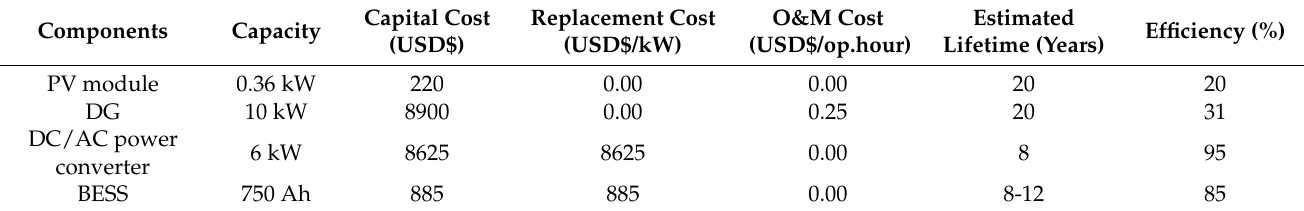
Table 2. Capacities, costs, lifetimes, and efficiencies of system